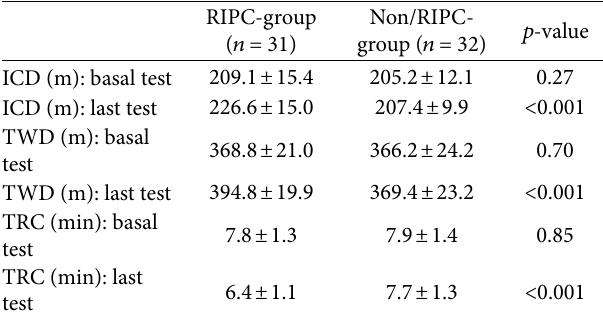
Table 3: Treadmill test parameters between